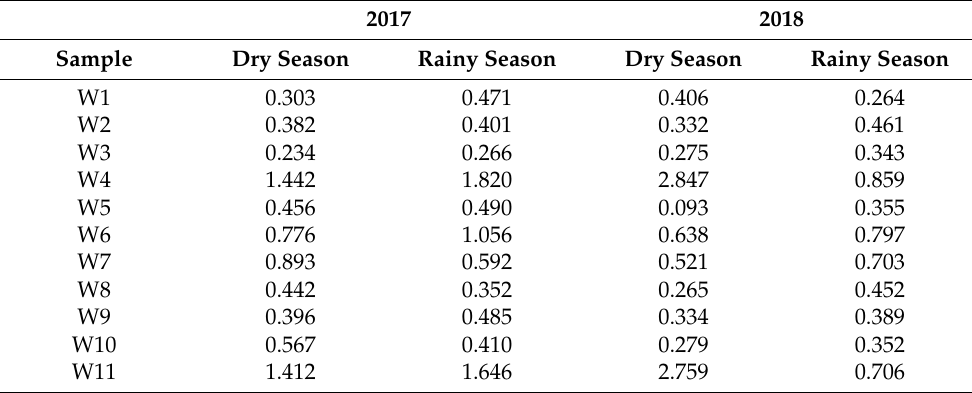
Table 7. Carcinogenic risk assessment for